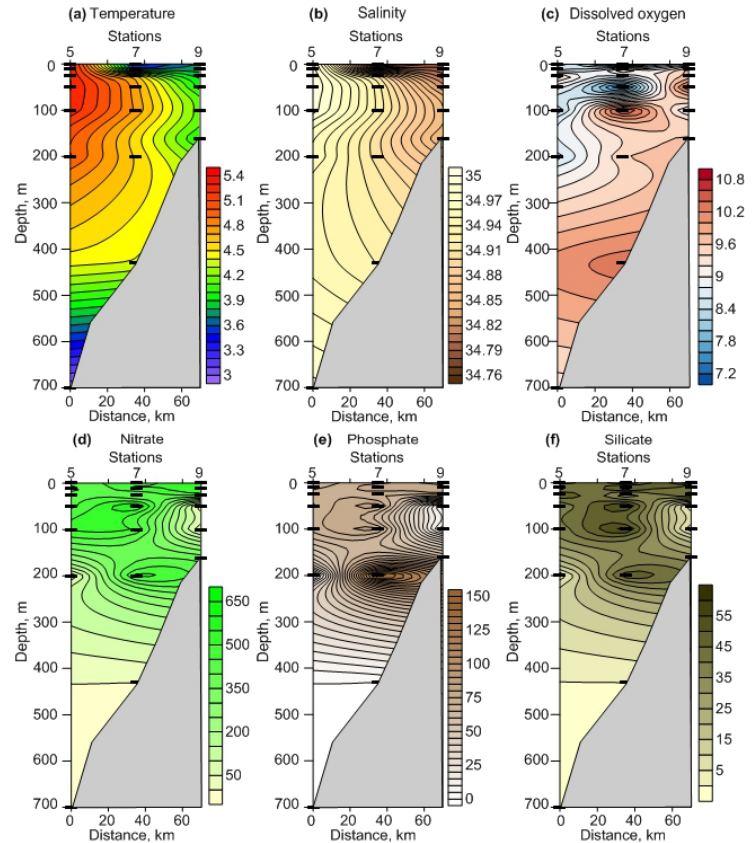
Figure 2. Vertical profiles of water temperature, °C ( a ), salinity, psu ( b ), dissolved oxygen, mL L − 1 ( c ), nitrate, μ g L − 1 ( d ), phosphate, μ g L − 1 ( e ), and silicate, μ g L − 1 ( f ) in the Fram Strait, winter 2021.